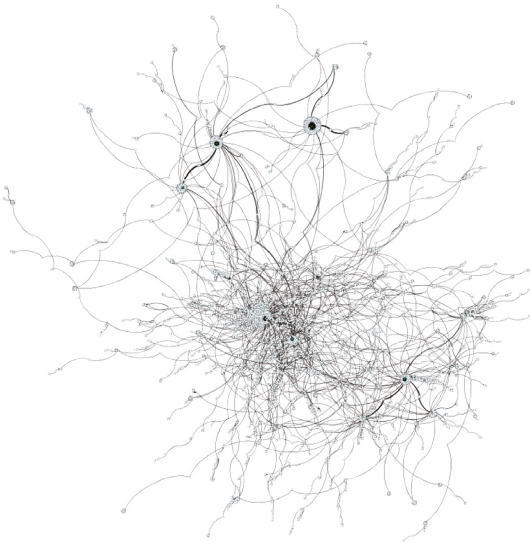
Figure 5: For quoting interactions, new links between nodes from April 12 until April 22 in 2021.